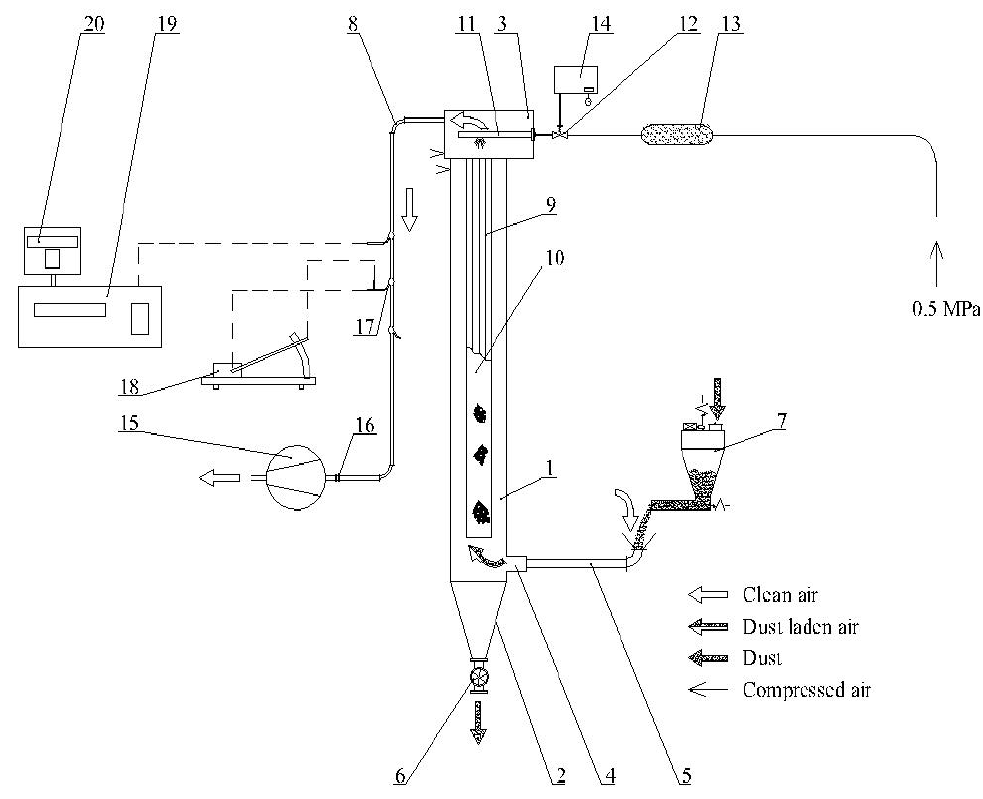
Figure 1. Test rig set-up: 1. filtering chamber, 2. hopper, 3. clean air chamber, 4. inlet, 5. dust inlet tube, 6. mucus feeder, 7. screw dust feeder DSK-I-04p (HYDRAPRESS, Białe Błota, Poland) 8. outflow pipe, 9. metal cage, 10. filtering bag, 11. cleaning nozzle, 12. electromagnetic valve, 13. compressed air tank, 14. The controlling device, 15. main fan, 16. gate valve, 17. Prandtl tube, 18. inclined-tube manometer type MPR-1 (ZAM Kety, Poland), 19. differential manometer type CMR-10 A (ZAM Kety, Poland), 20. printer.